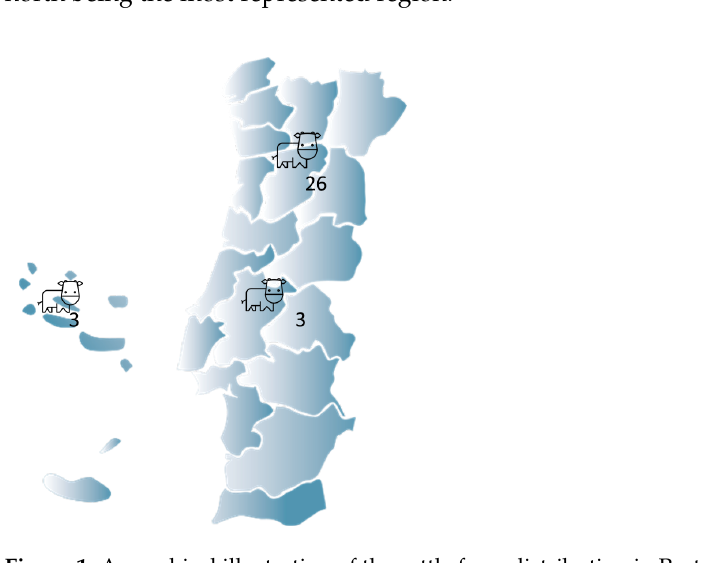
Figure 1. A graphical illustration of the cattle farm distribution in Portugal.